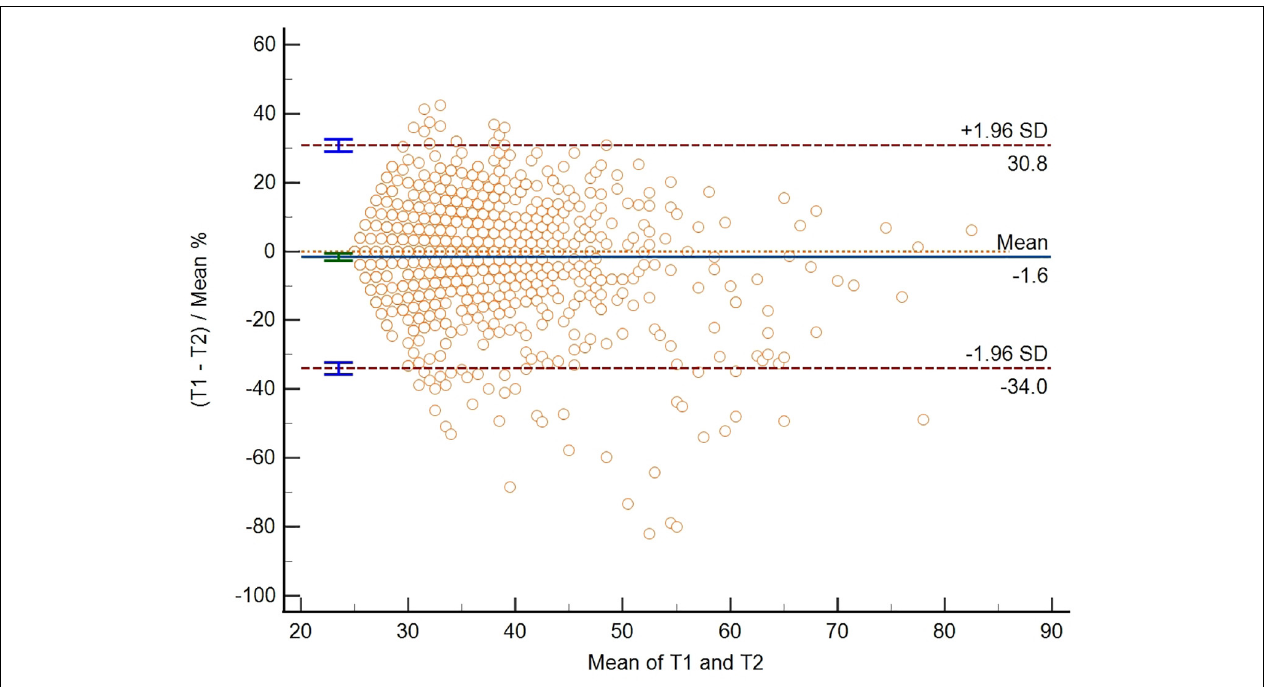
FIGURE 1 | The bias line and random error lines forming the 95% limits of agreement are presented on the plot. T1, the CTQ-SF score of the first measurement; T2, the CTQ-SF score of the second measurement; SD, standard